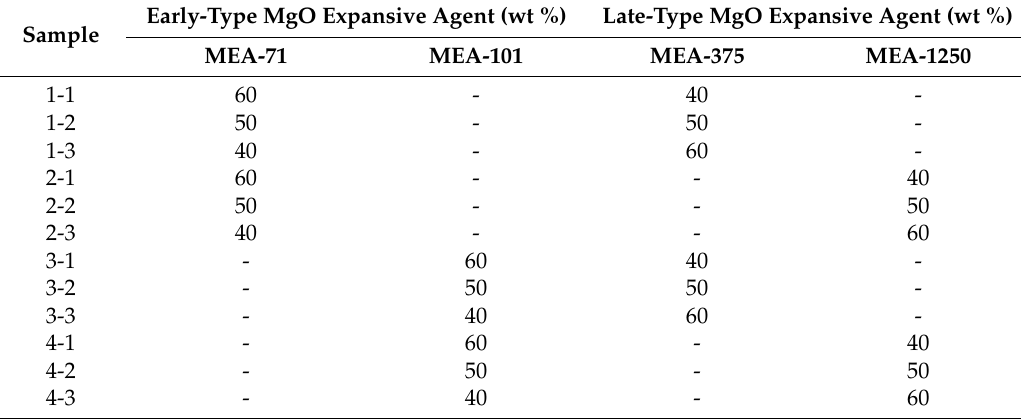
Table 3. Blending ratios of the blended